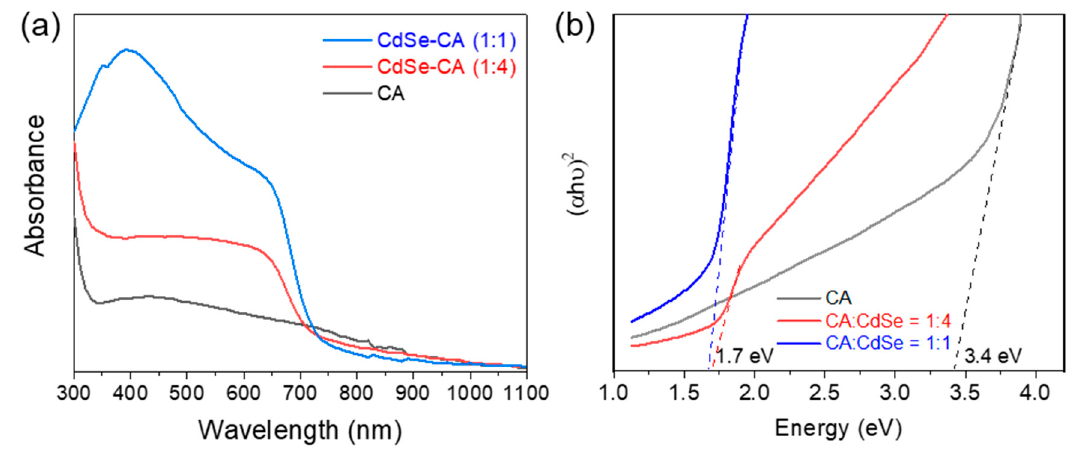
Figure 4. ( a ) UV-vis absorbance spectra (normalized at 1100 nm) and ( b ) Tauc plot of CA, CdSe-CA (1:4), and CdSe-CA (1:1) fibers.